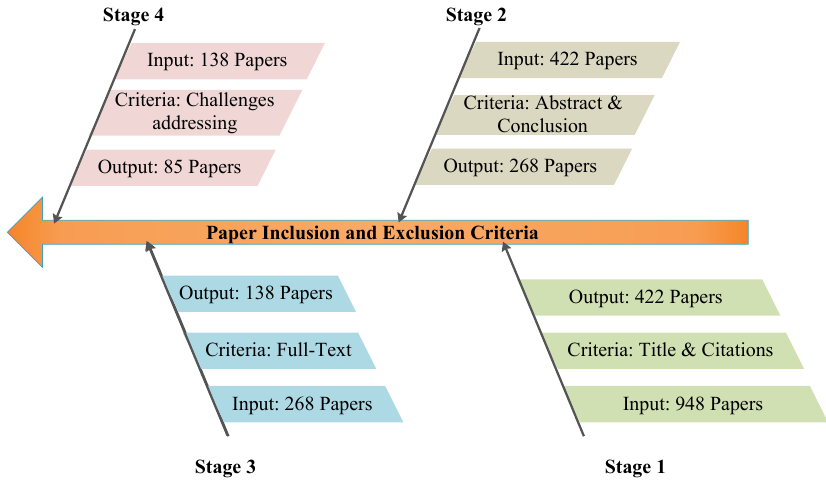
Figure 2. Criteria of inclusion and